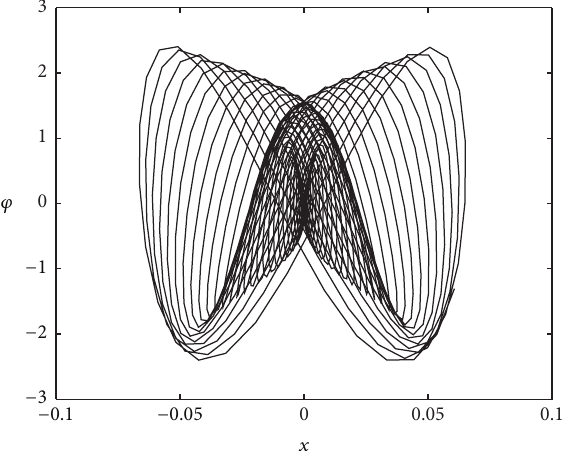
Figure 12: Diagram displaying the portrait of 𝑥 against 𝜑 when 𝜔 2 = 0.4